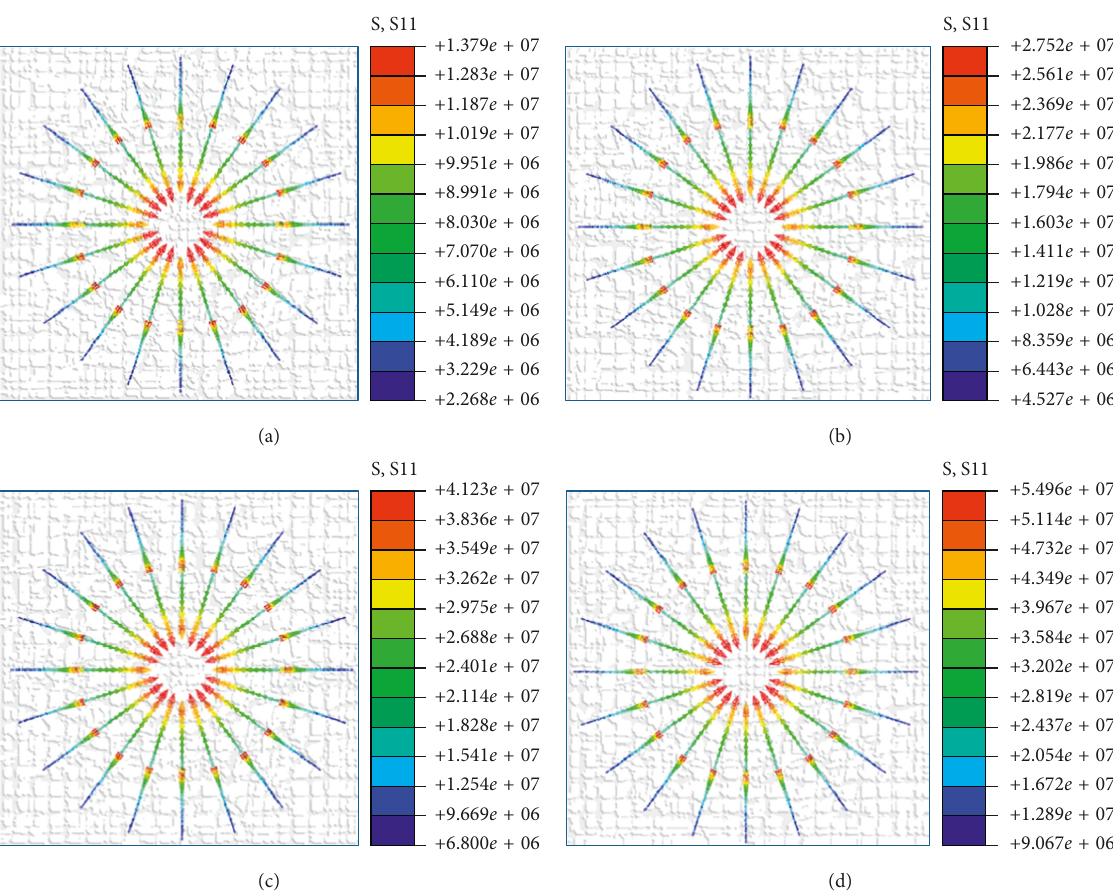
Figure 10: Axial force distribution of bolt with different stress release coefficients. (a) α